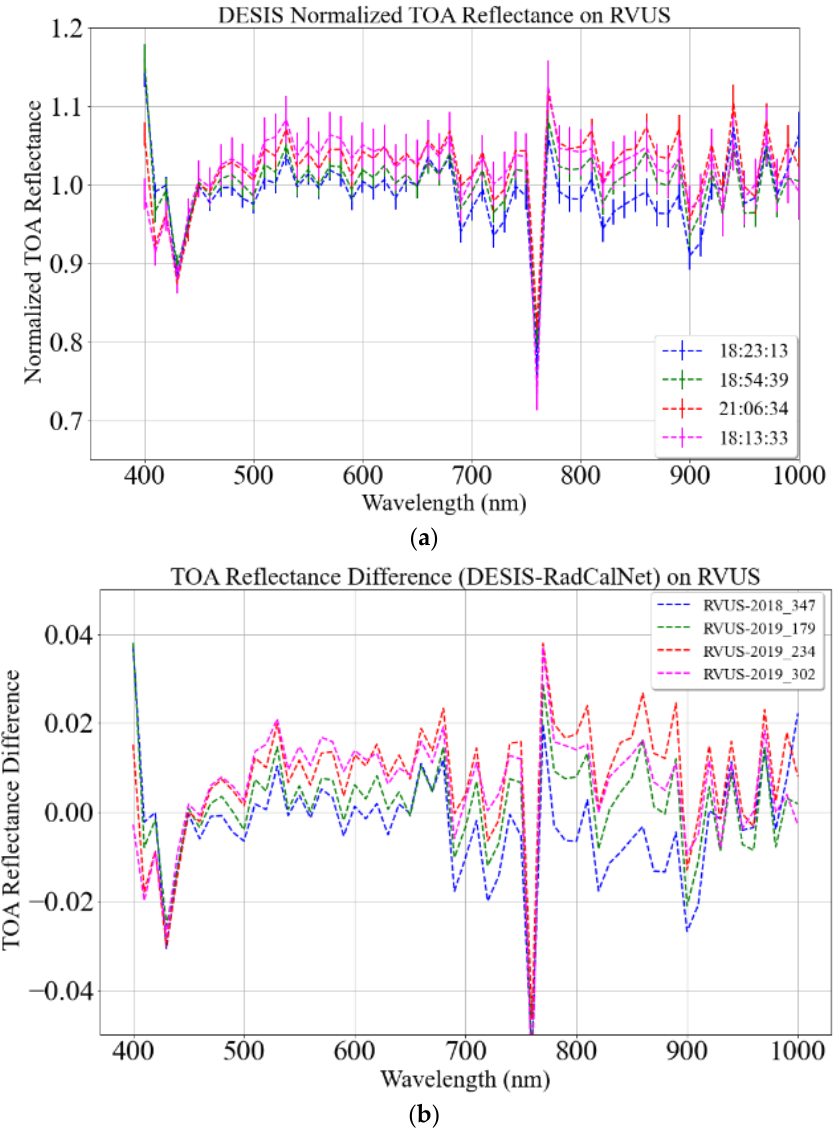
Figure 7. DESIS normalized TOA reflectance on RVUS ( a ). Absolute TOA difference between DESIS and RadCalNet TOA reflectance ( b ).